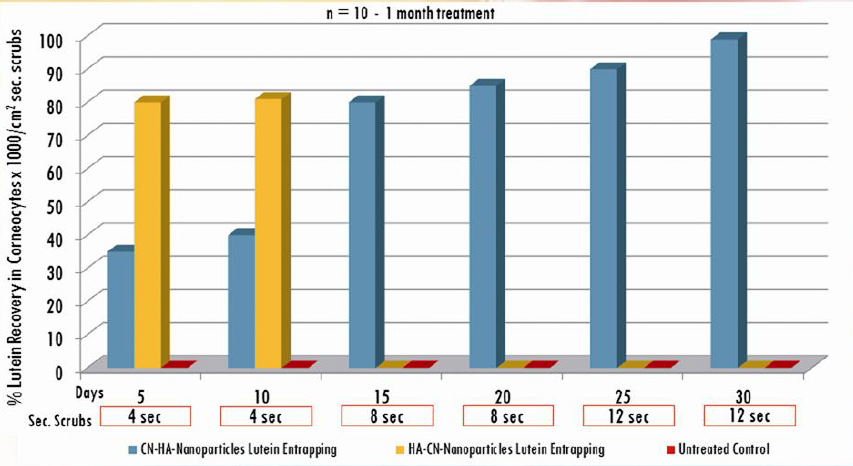
Figure 7. Lutein recovery of corneocytes removed from forearm by forced scaling at different times and days of treatment by nanoparticles entrapping lutein. All p values are significant ( p < 0.005) as control and as each other groups.